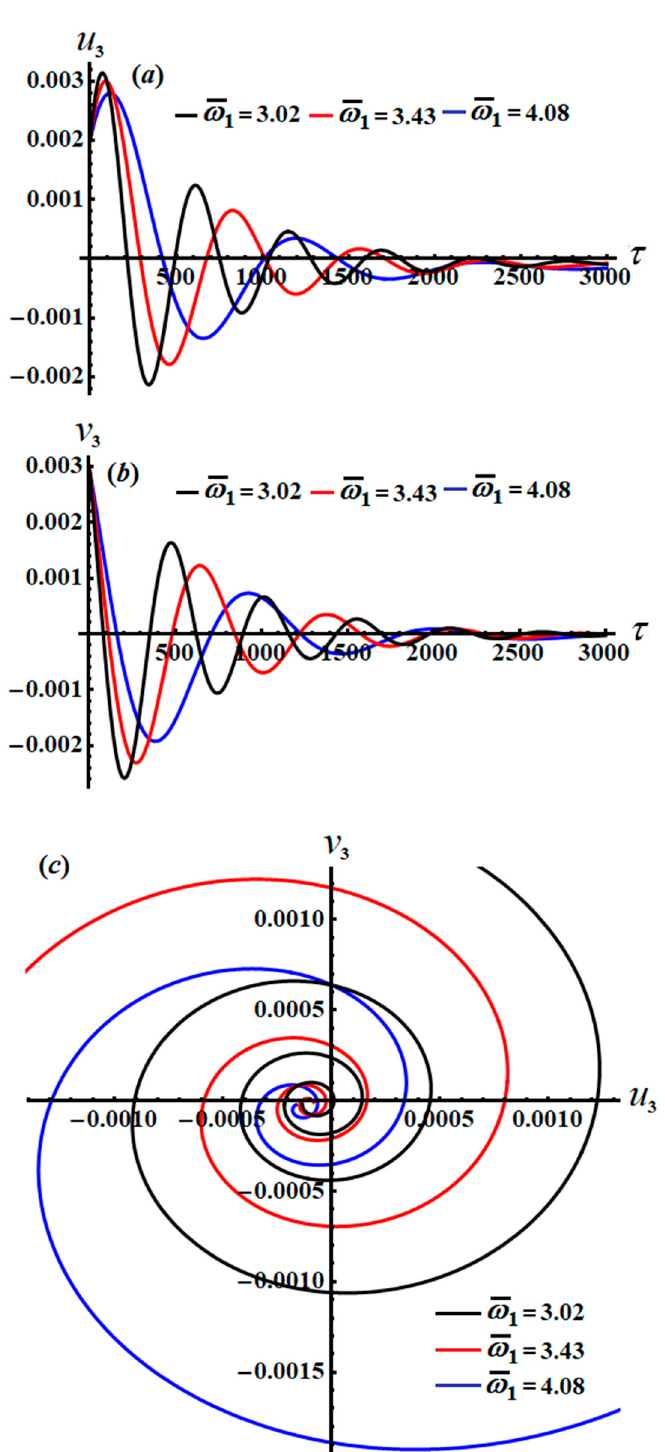
τ and the projections of the modulation equation tracks ω = .